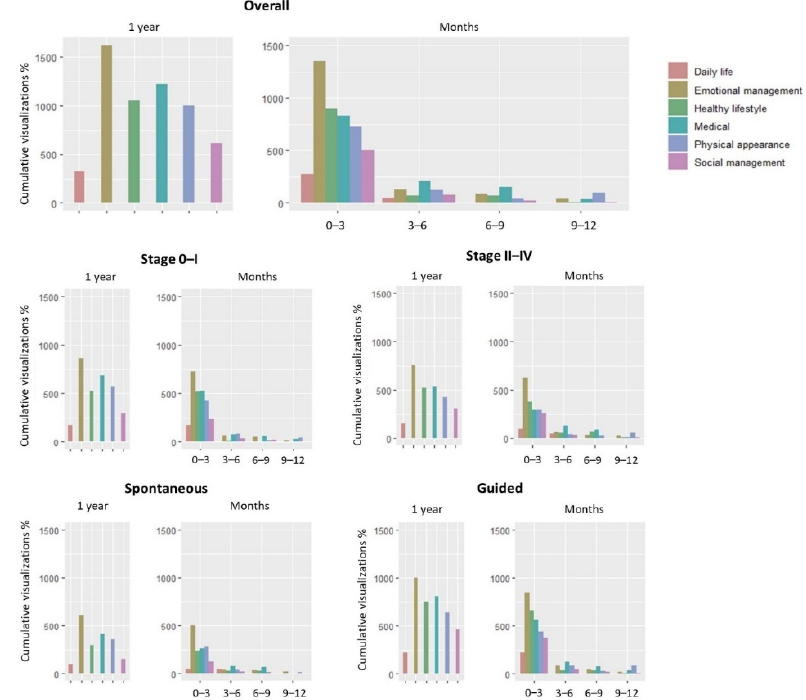
Figure 1. Utilization of resources over time.